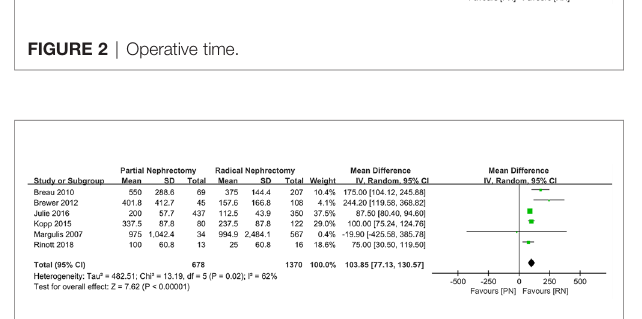
FIGURE 3 | Estimated blood loss.